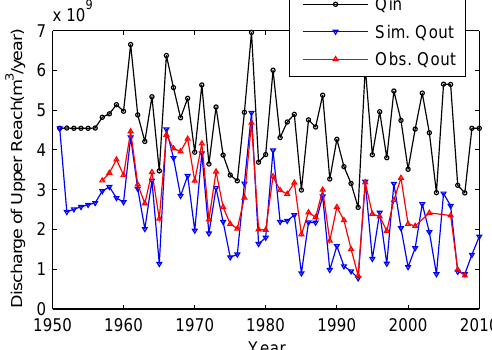
Figure 5. Discharge of the upper reach of the Tarim River. The out- flow ( Q out ) of the upper reach is the inflow of the lower reach.